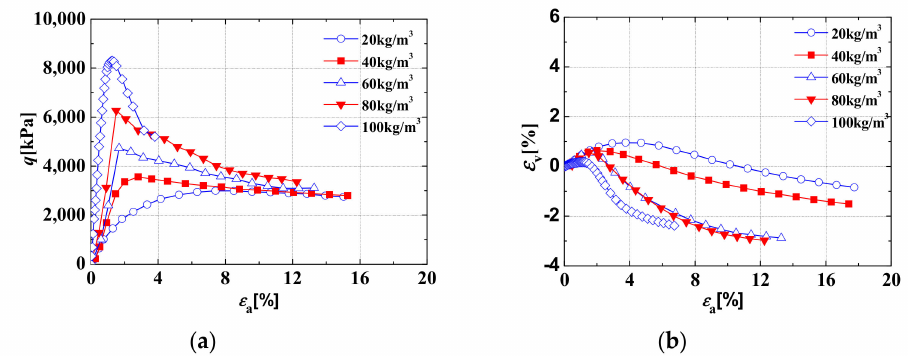
Figure 2. The curves of the triaxial tests for CSG material with the confining pressure of 600 kPa: ( a ) the stress–strain curves; ( b ) the volumetric strain-axial strain curves.